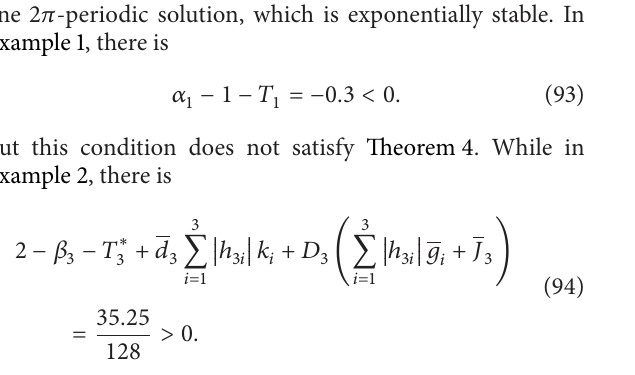
Figure 11: Transient response of state variables V 2 (𝑡) of Example 2.